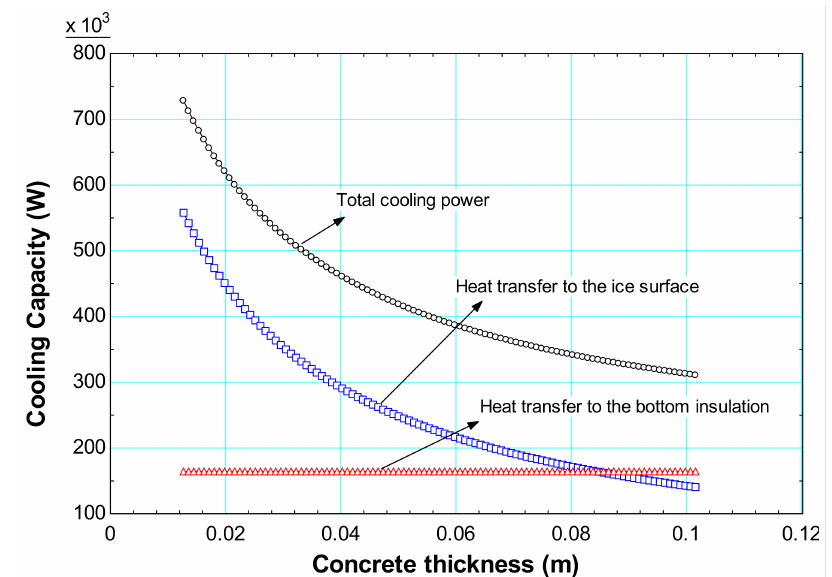
Figure 9. Cooling performance with different concrete